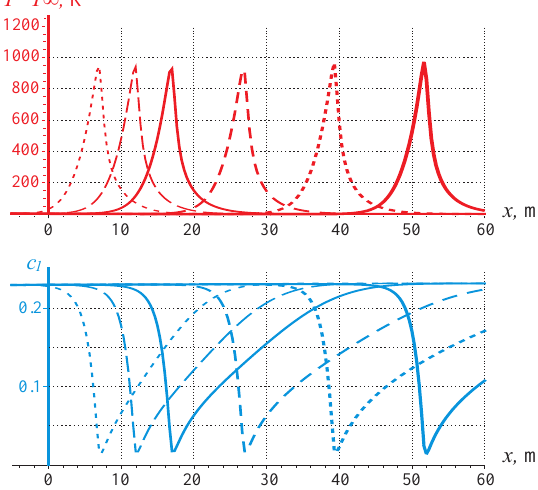
Figure 5. Profiles of temperature and oxygen concentration at steady forest fire propagation at moments of time t = 1 , 2 , 3 , 5 , 7 . 5 and 10